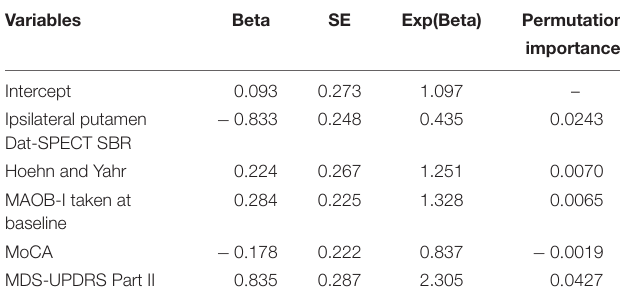
TABLE 4 | Data Driven model 1 to predict motor progression in individuals with PD.